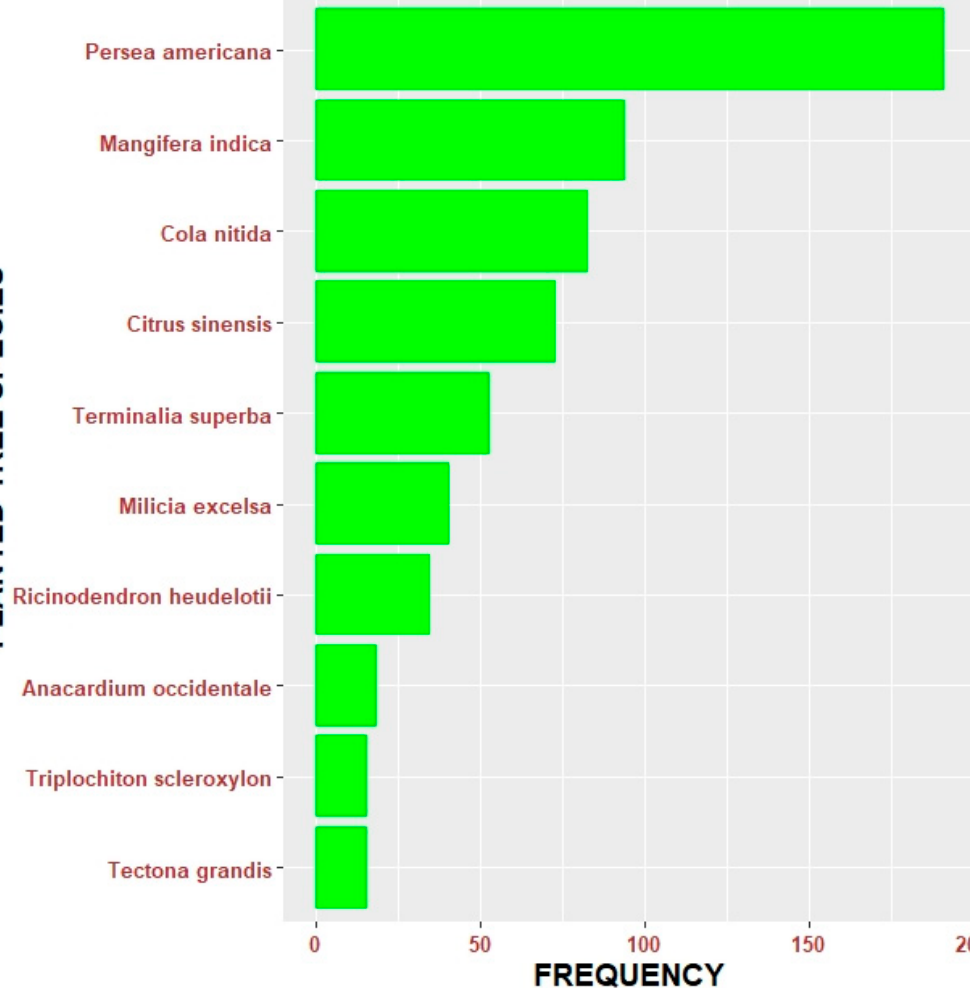
Figure 2. Farmers’ expected benefits from planted trees on cocoa farms in Côte d’Ivoire. Forests 2020 , 11 , x FOR PEER REVIEW